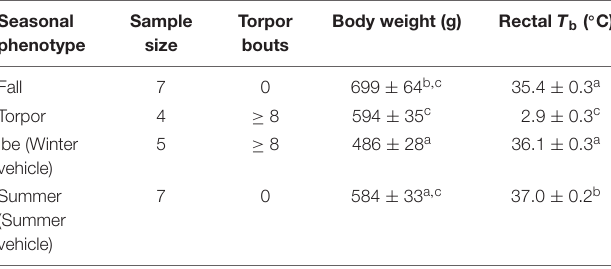
TABLE 1 | Characteristics of each seasonal phenotype.